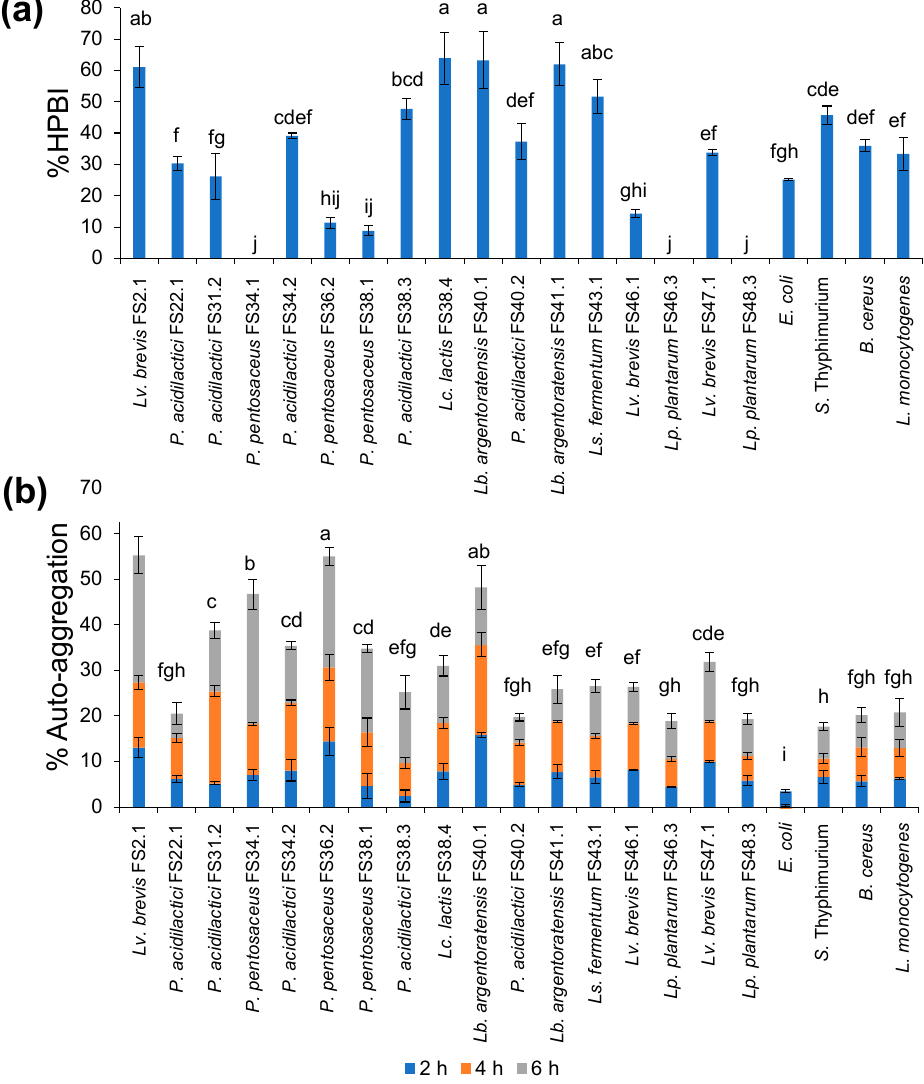
Figure 3. Percentages of HPBI ( a ) and AA ( b ) of the selected XOSs-fermenting LAB. Lower-case letters indicate statistical differences in values at p < 0.05.